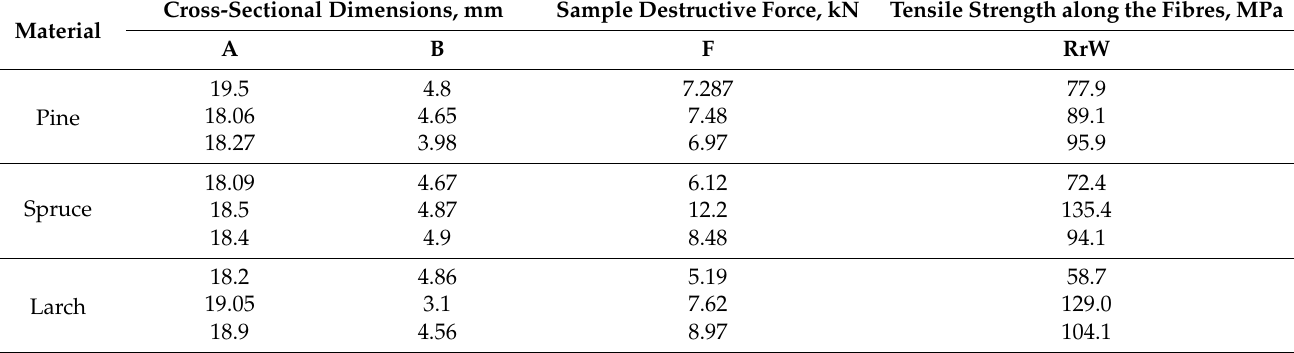
Table 3. Tensile testing along the fibres of respective cycle 2 materials.